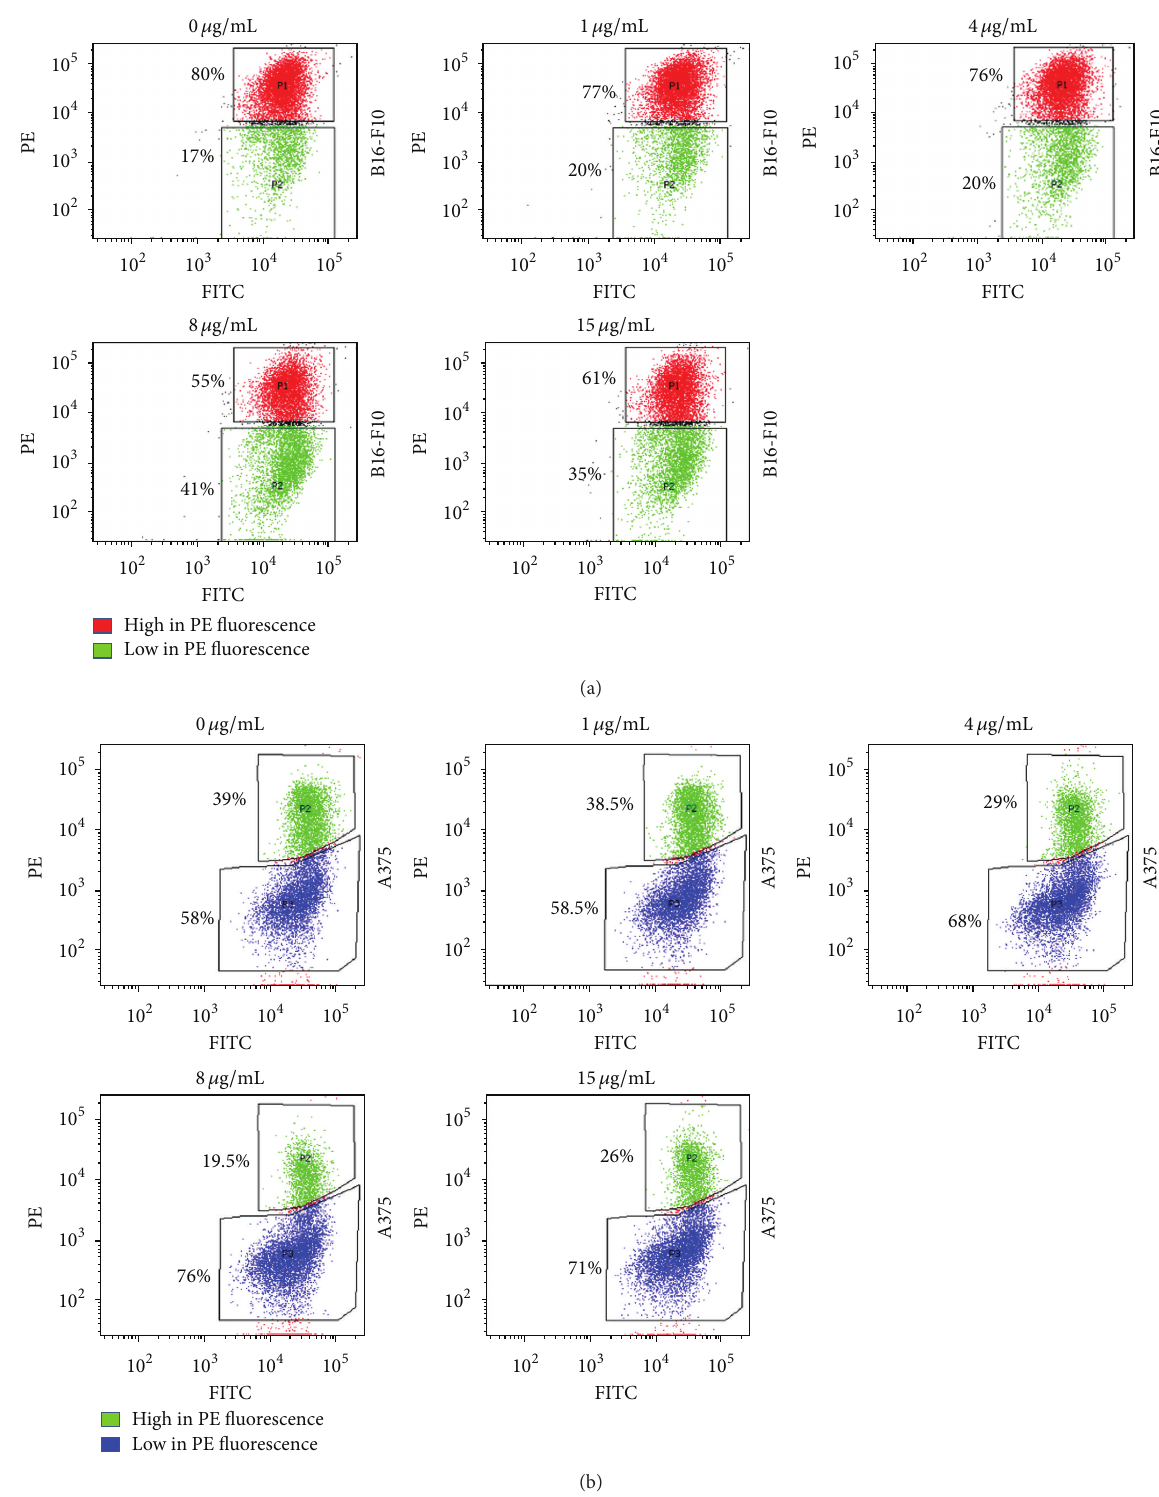
Figure 7: p-PD depolarizes mitochondrial membrane potential of both melanoma cells. p-PD treated (as indicated for two hours) and untreated (0 𝜇 g/mL) melanoma cells were subjected to JC 1 staining for the measurement of MMP. For both cell lines, cell clusters which are high in PE fluorescence are gated in the top of each dot plot (red and green for B16-F10 and A375 cells, resp.) presenting the healthy cell population. Cell clusters that are gated for low PE fluorescence in the bottom part of each dot plot (green and blue for B16-F10 and A375 cells, resp.) are representing the cells with depolarized mitochondria. Cell percentage values of the gated population are stating the effect of p-PD in the polarization of mitochondria. One piece of the representative experimental data is shown here. Each set was performed in